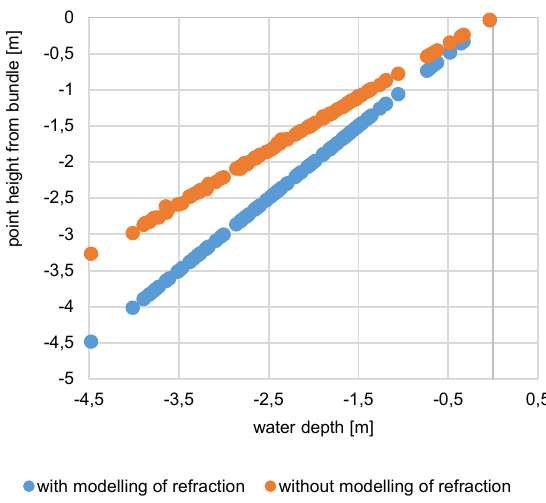
Figure 3. Comparison of height values of tie points against water depth from bundle adjustment with and without modelling of refraction.